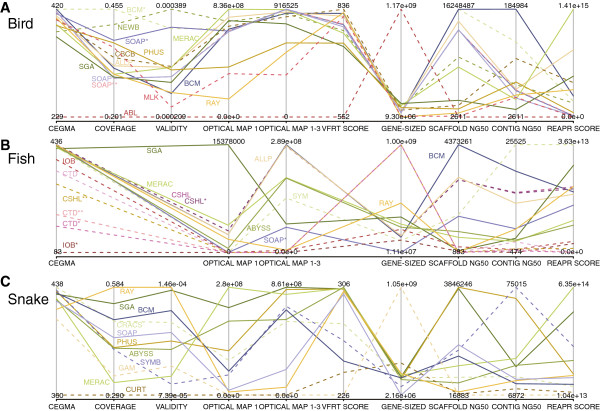
Parallel coordinate mosaic plot showing performance of all assemblies in each key metric. Performance of bird, fish, and snake assemblies (panels A–C) as assessed across ten key metrics (vertical lines). Scales are indicated by values at the top and bottom of each axis. Each assembly is a colored, labeled line. Dashed lines indicate teams that submitted assemblies for a single species whereas solid lines indicate teams that submitted assemblies for multiple species. Key metrics are CEGMA (number of 458 core eukaryotic genes present); COVERAGE and VALIDITY (of validated Fosmid regions, calculated using COMPASS); OPTICAL MAP 1 and OPTICAL MAP 1–3 (coverage of optical maps at level 1 or at all levels); VFRT SCORE (summary score of validated Fosmid region tag analysis), GENE-SIZED (the amount of an assembly’s scaffolds that are 25 Kbp or longer); SCAFFOLD NG50 and CONTIG NG50 (the lengths of the scaffold or contig that takes the sum length of all scaffolds/contigs past 50% of the estimated genome size); REAPR SCORE (summary score of scaffolds from REAPR tool).